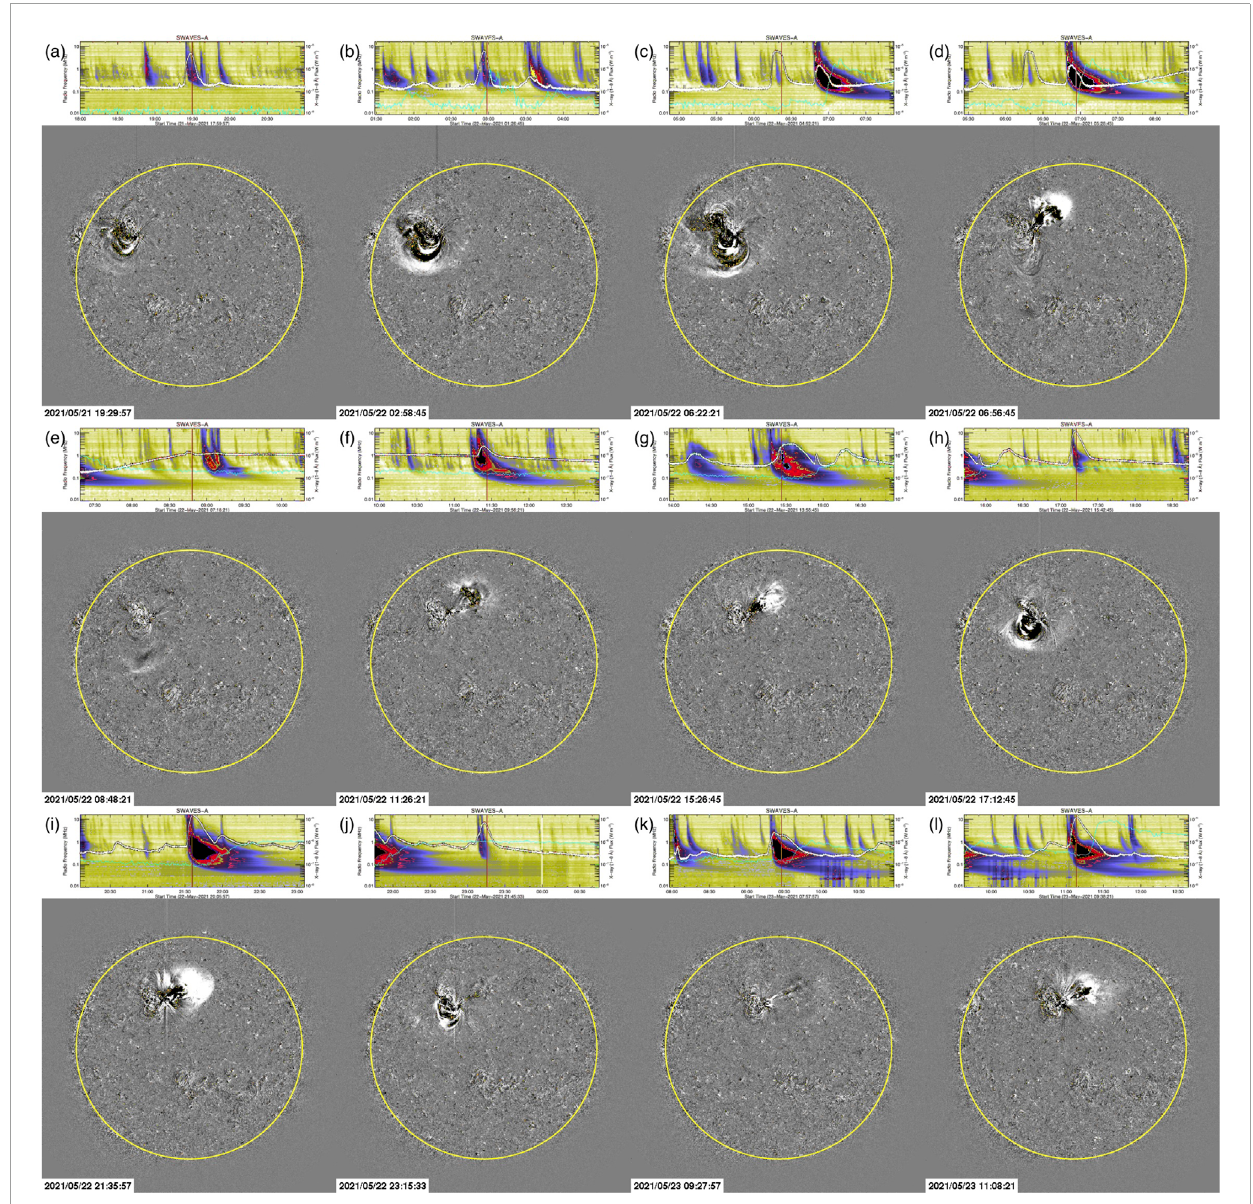
FIGURE 8 AIA 211 Å running difference images showing EUV waves that occurred in AR 12824 during 21–23 May 2021. The yellow circles indicate the solar disk. In (D,F,G,I–L) , the EUV wave started as a jet. In others, the wave started as an outward motion of large-scale closed loops (see